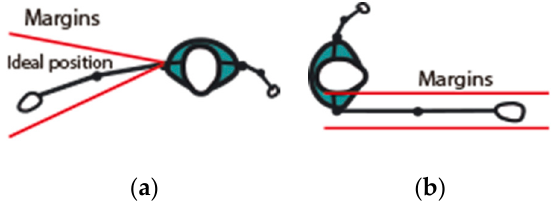
Figure 4. Tolerance margins for abduction ( a ) and flexion ( b ).